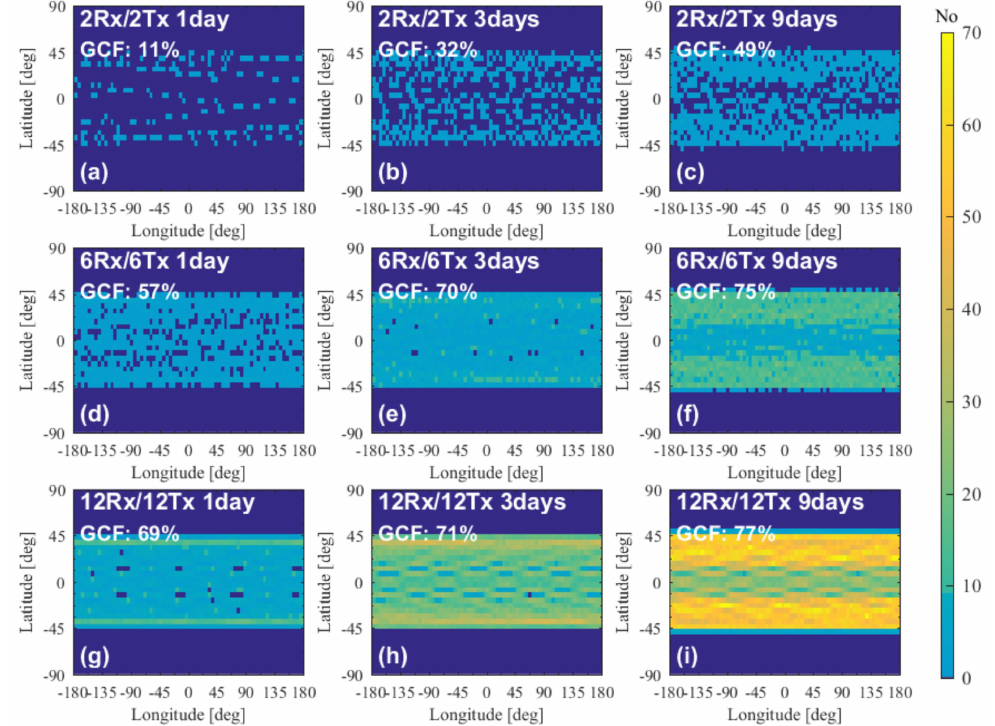
Figure 13. The global coverage of LEO-LEO occultation events for the 2Rx/2Tx, 6Rx/6Tx, and 12Rx/12Tx constellations with the Rxi140 and Txi40 inclination orbital planes, illustrating the occul- tation numbers per 5 ◦ × 5 ◦ latitude and longitude grid cell. The GCFs were calculated using grid cell areas according to Equation